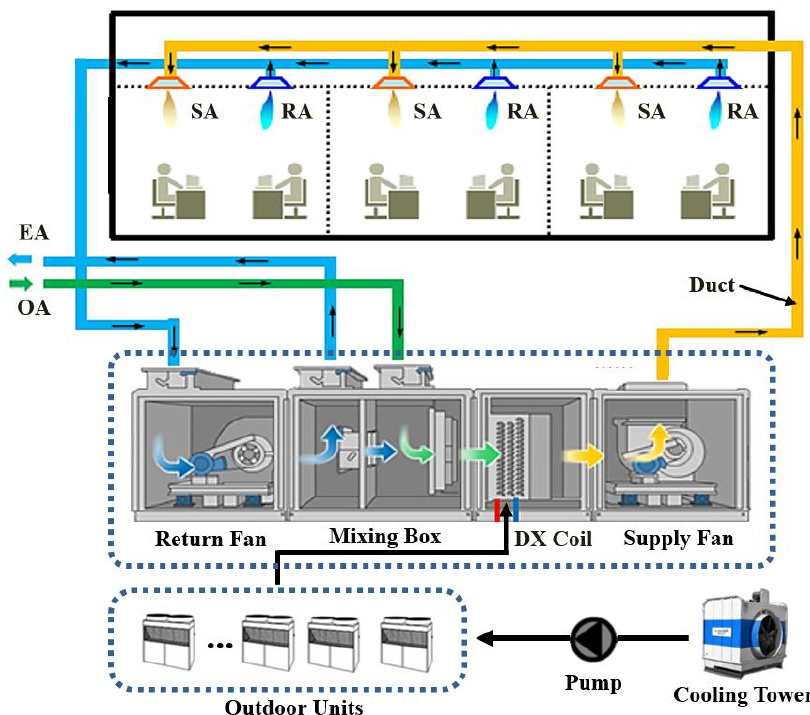
Figure 1. Diagram of the direct expansion DX air handling unit (AHU)-water source variable refrigerant flow (VRF) system. SA: supply air; RA: return air; EA: exhaust air; OA: outdoor